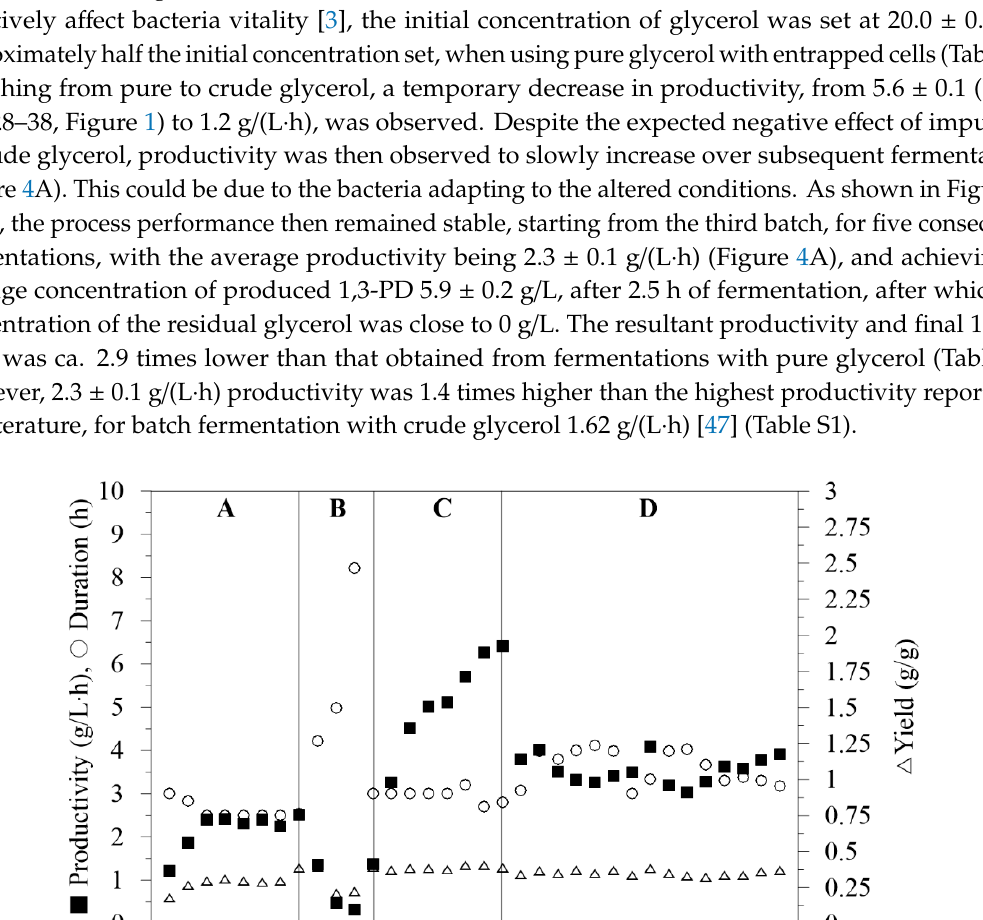
Figure 5. Seven repeated batch fermentations of the UCO-derived crude glycerol (initial concentration: 20.0 ± 0.2 g/L) with the immobilized cells. 2.7. Revitalization Protocol